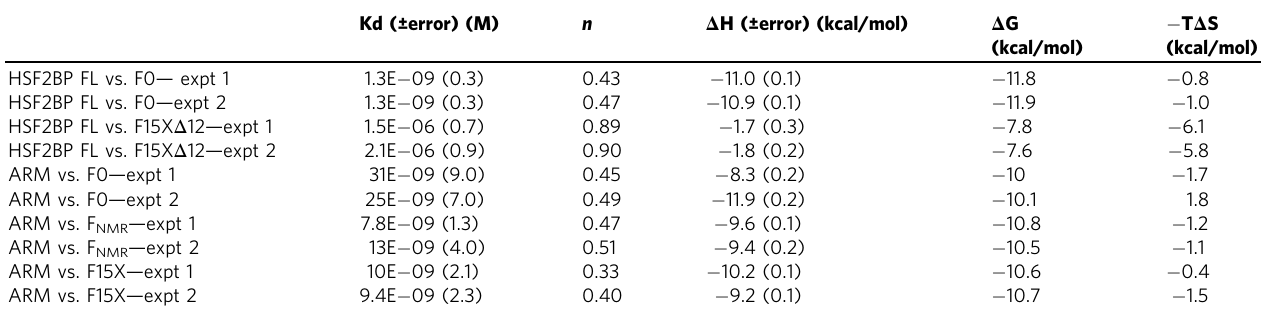
Table 1 Isothermal titration calorimetry